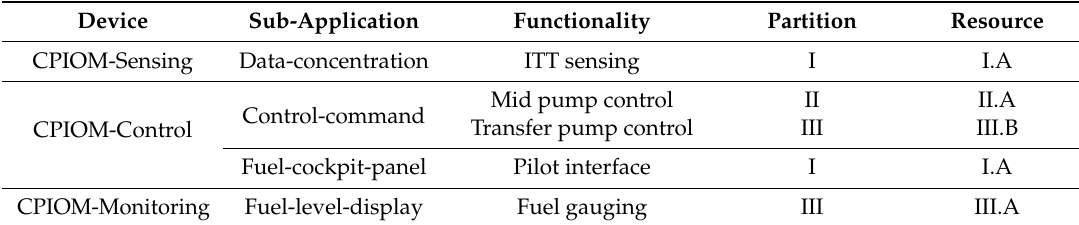
Table 2. Allocation of deployed sub-applications (scenario 2).